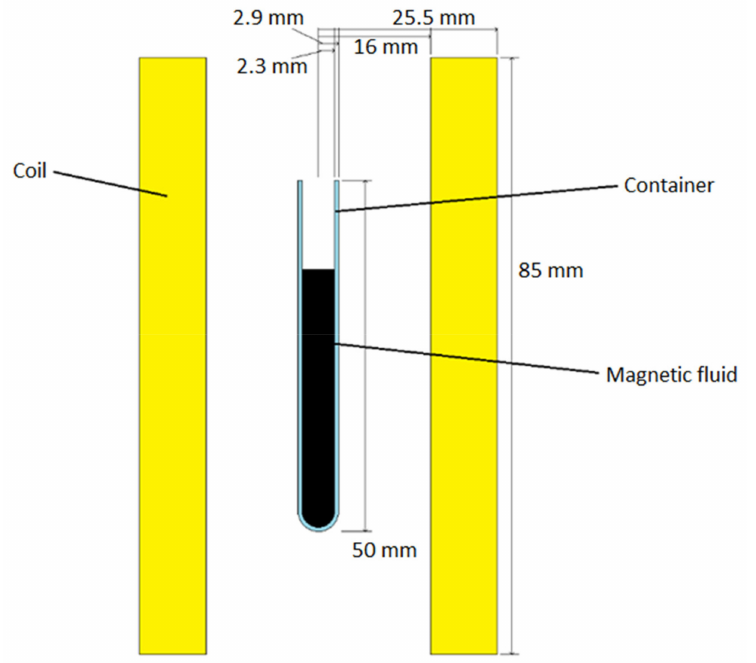
Figure 2. Schematic representation of the model’s